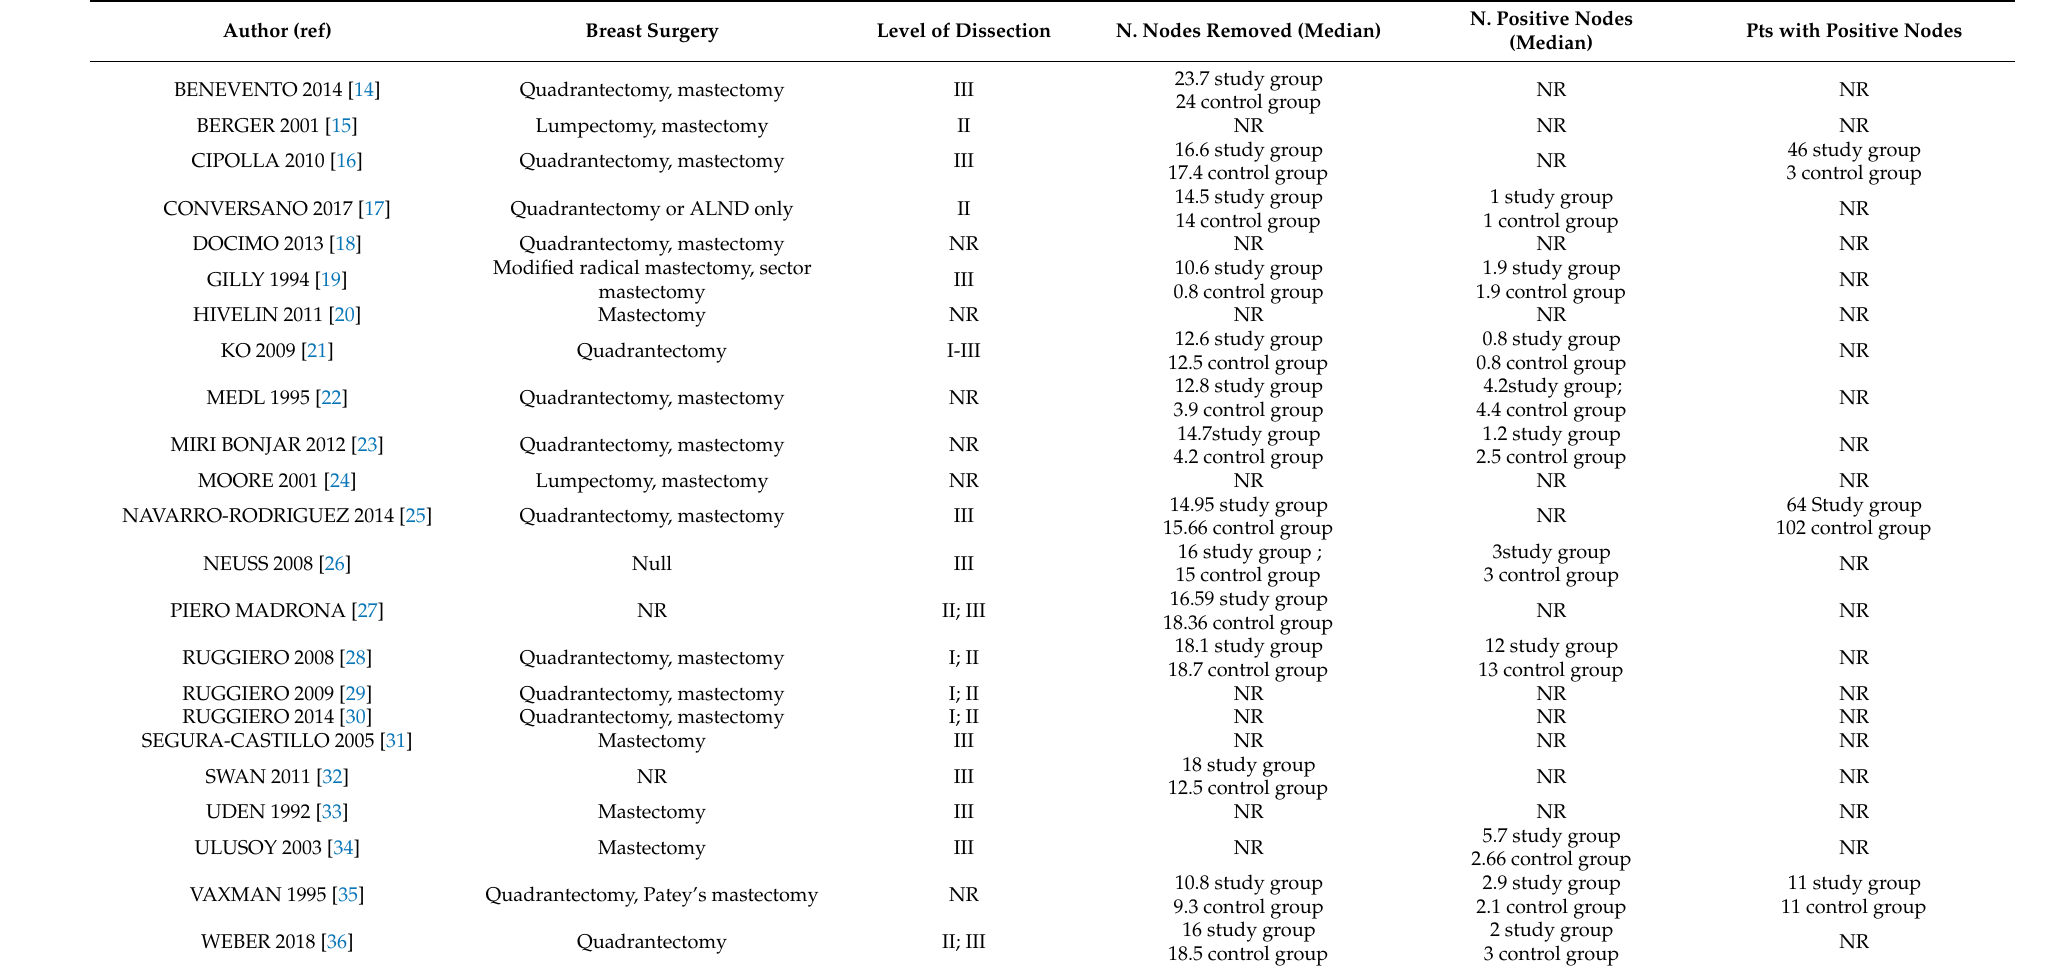
Table 2. Surgical